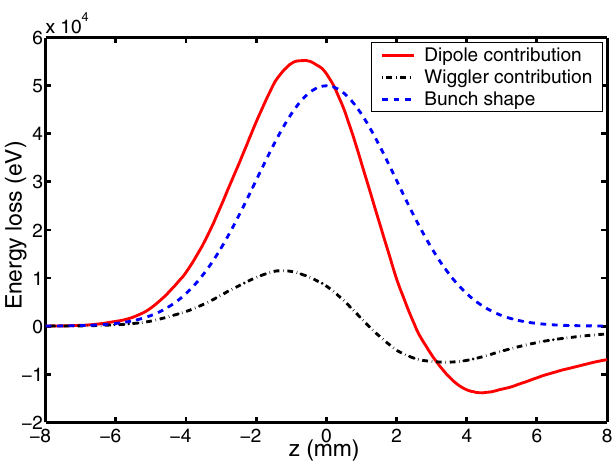
FIG. 8. (Color) Comparison between the dipole and the wiggler contribution to the energy loss of a particle in a 2 mm Gaussian bunch.